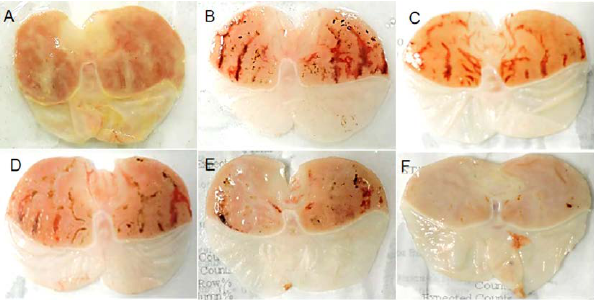
Figure 1. Gastric ulcer area of ethanol-induced ulceration in rats. ( A ) Vehicle control; ( B ) ulcer control; ( C ) ExPhy (100 mg/kg); ( D ) ExPhy (200 mg/kg); ( E ) ExPhy (400 mg/kg); ( F ) omeprazole (40 mg/kg). Table 3. Effect of ExPhy and omeprazole on ulcer parameters in rats with ethanol-induced ulcers.